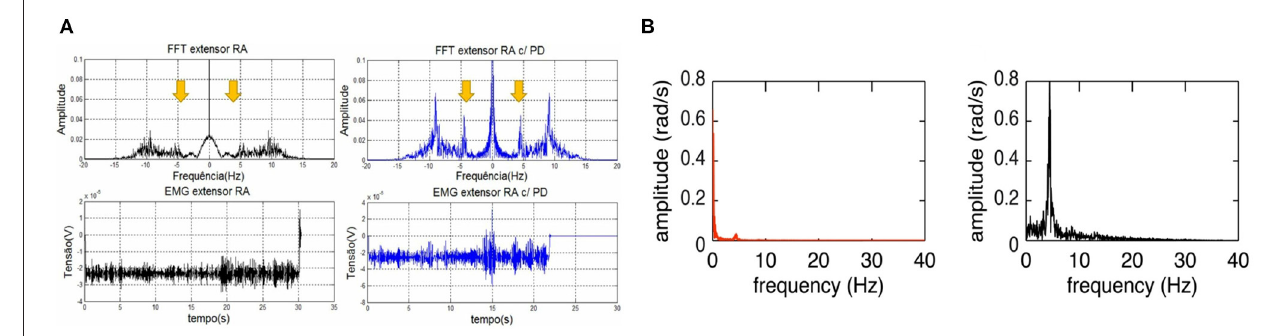
FIGURE 5 | Frequency characteristics of PD tremor based on the EMG signals and inertial data. (A) Comparison of temporal and spectral features of EMG signal in the wrist extensor muscle between a PD patient (blue) and healthy person (black). The spectral-domain plot of PD patient’s EMG exhibits an additional tremor frequency at 4.55Hz (Castro et al., 2017). (B) Comparison of spectral features of wrist joint angular velocity between resting tremor (black) and voluntary movement (red) in a PD patient. Voluntary movement has a much lower frequency (0–2Hz) compared to that of Parkinsonian tremor (Lambrecht et al.,